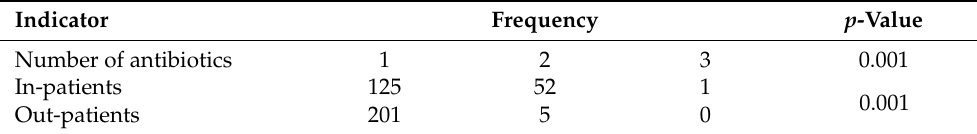
Table 4. Number of antibiotics per prescription.